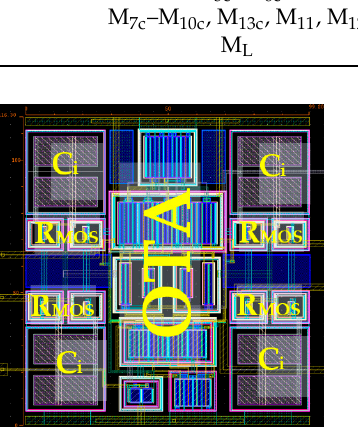
Figure 7. The layout of the MI-G m .